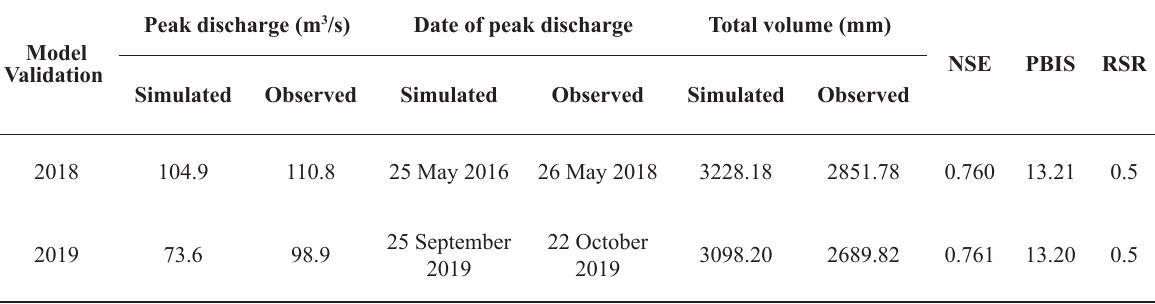
Table 3: Model performances statistics and summary of the performance of the HEC-HMS model for the validation periods.